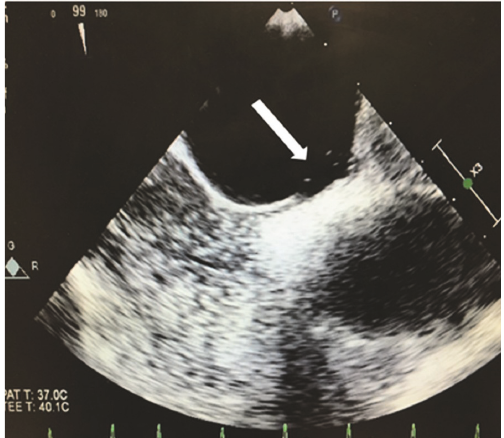
Figure 6: White arrow showing 3 bubbles crossing the atrial septum on transesophageal